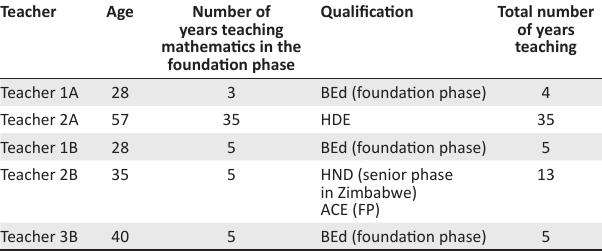
TABLE 1: Information about